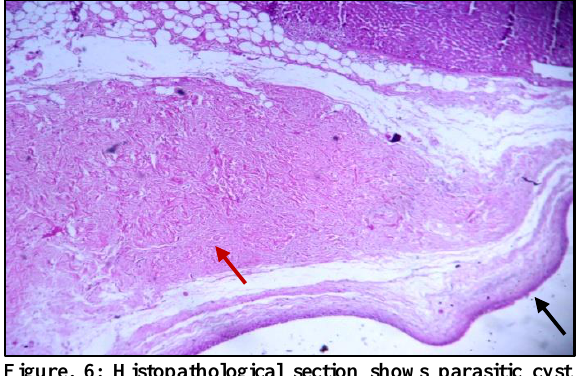
Figure, 6: Histopathological section shows parasitic cyst ( ) in the hepatic parenchyma induced fibroma ( ) which consisting of whorls and interlacing bundles of fibroblasts and collagen fibers (H and E x100).